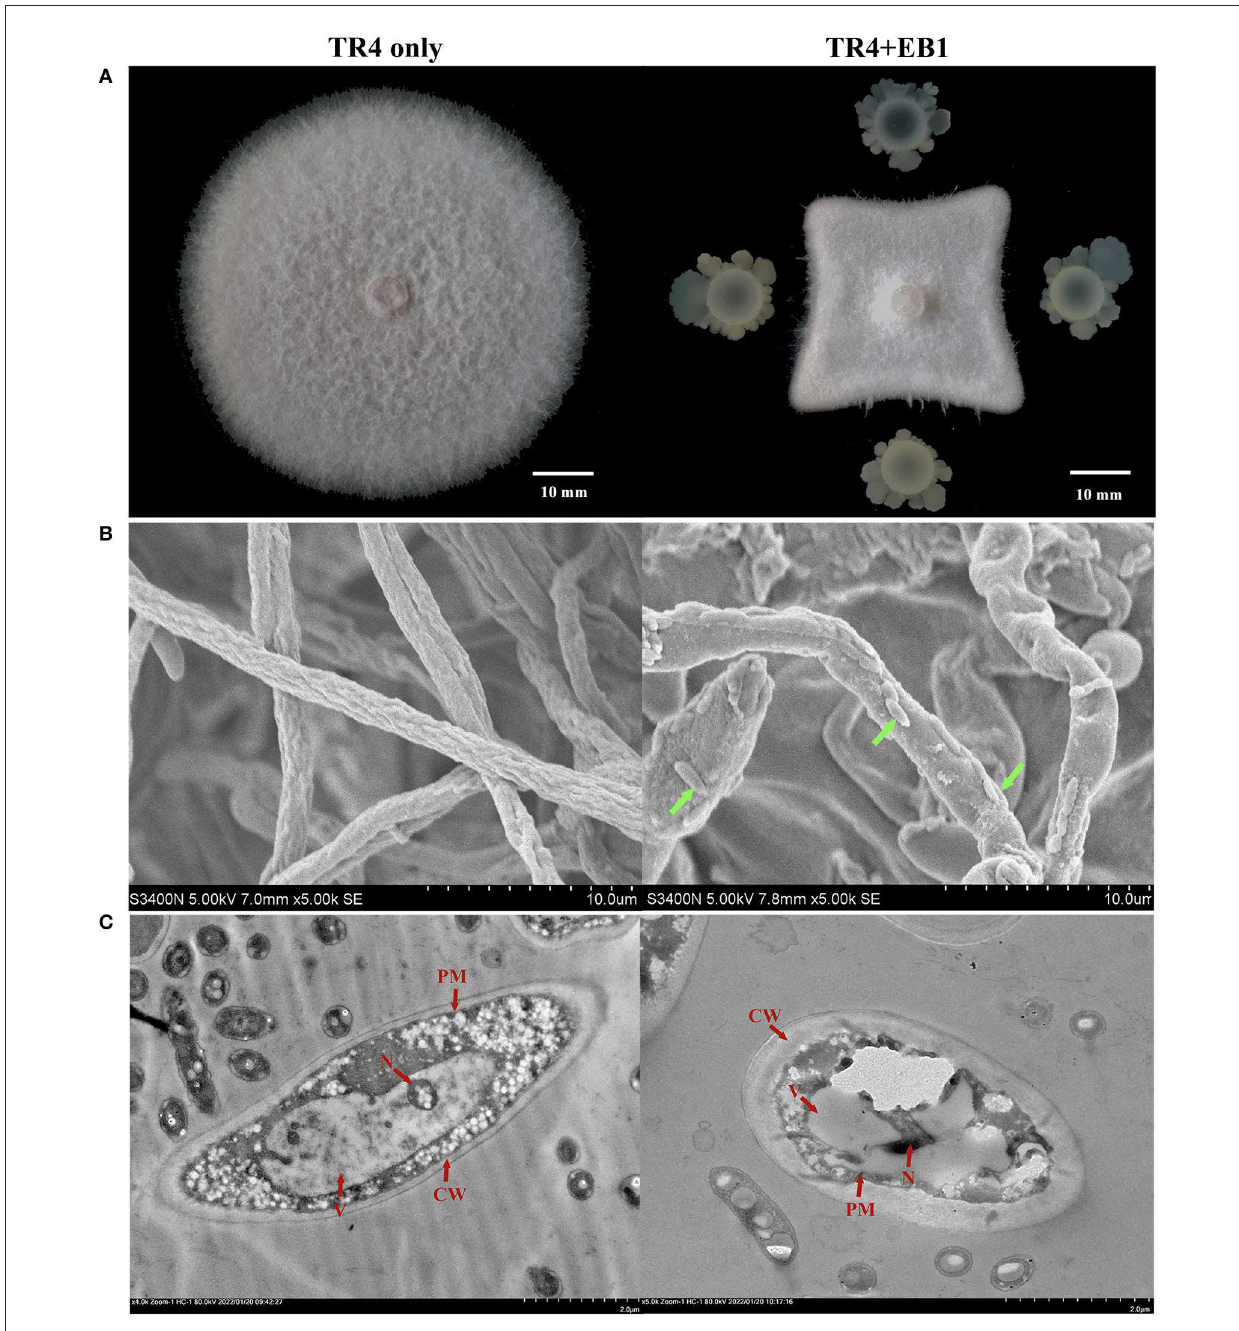
FIGURE1 The antagonistic potential of strain EB1 against Fusarium oxysporum f. sp. cubense tropical race 4 ( Foc TR4). (A) The antagonistic potential of EB1 against TR4 in vitro with a dual-culture experiment. Morphological (marked by green arrow heads) and ultrastructural changes (marked by red arrow heads) of TR4 after the confrontation with EB1 were scrutinized by scanning electron microscopy (SEM) (B) and transmission electron microscope (TEM) (C) ,